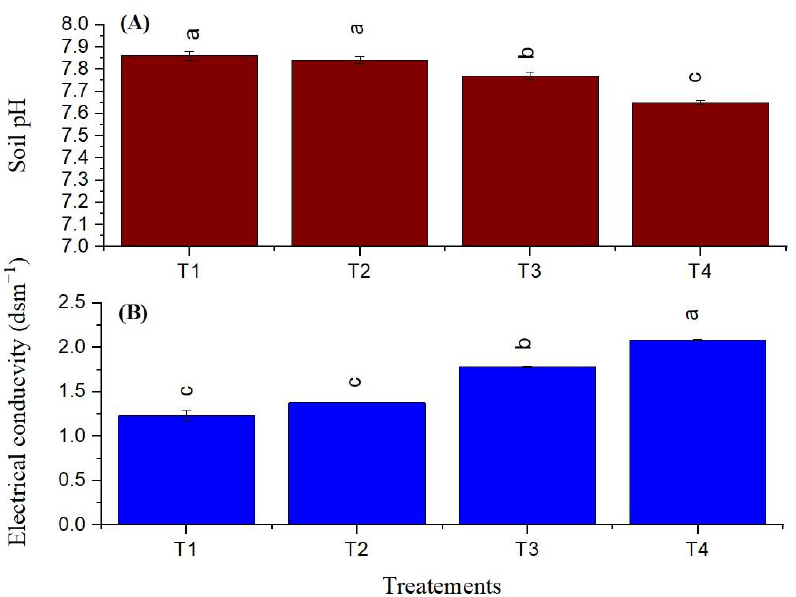
Figure 4. Effect of gypsum treatments on the ( A ) soil pH and ( B ) soil electrical conductivity (EC). These values of soil pH and EC are for the soil with 0 – 15 cm of depth. Different lowercase letters indicated the significant difference between treatments at p < 0.05.